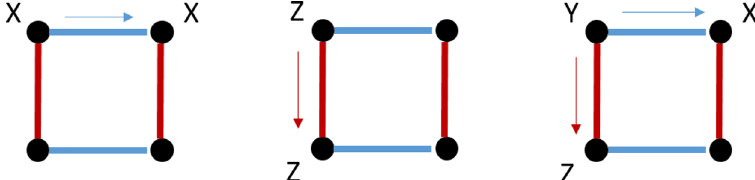
Figure 10. Pushing using gauge operators. Pushing of a weight one Pauli operator by multiplying gauge operators. This can “push” the operator onto at most two sites, but it can not be pushed across the